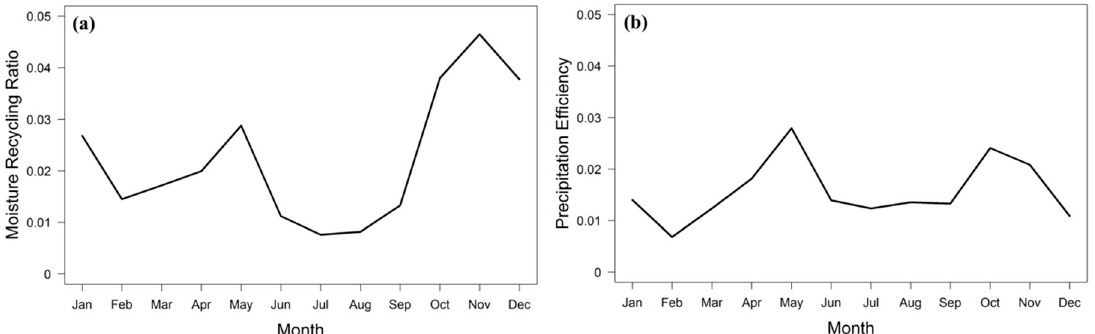
Figure 11. Annual changes in the moisture recycling ratio ( a ) and the precipitation efficiency ( b ) for the ENB during the period 1998–2001, as simulated from the WRF model.